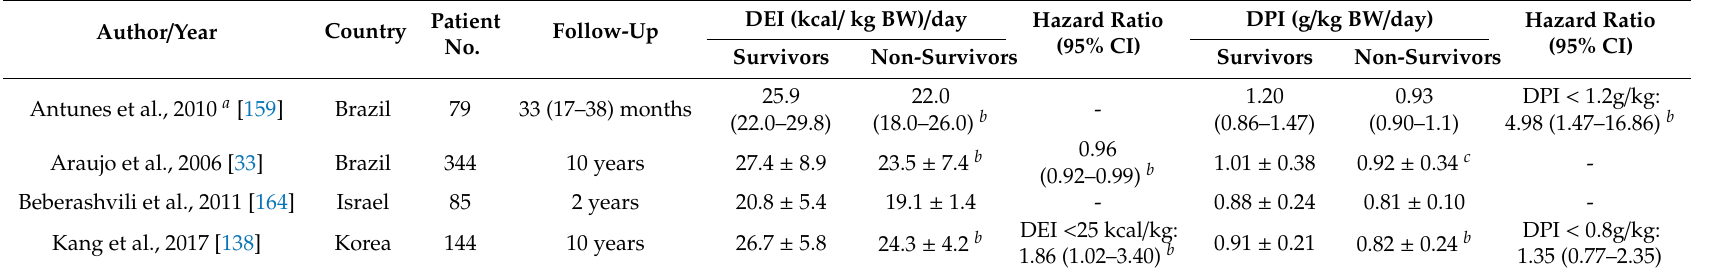
Table 6. Suboptimal dietary intakes and mortality in HD